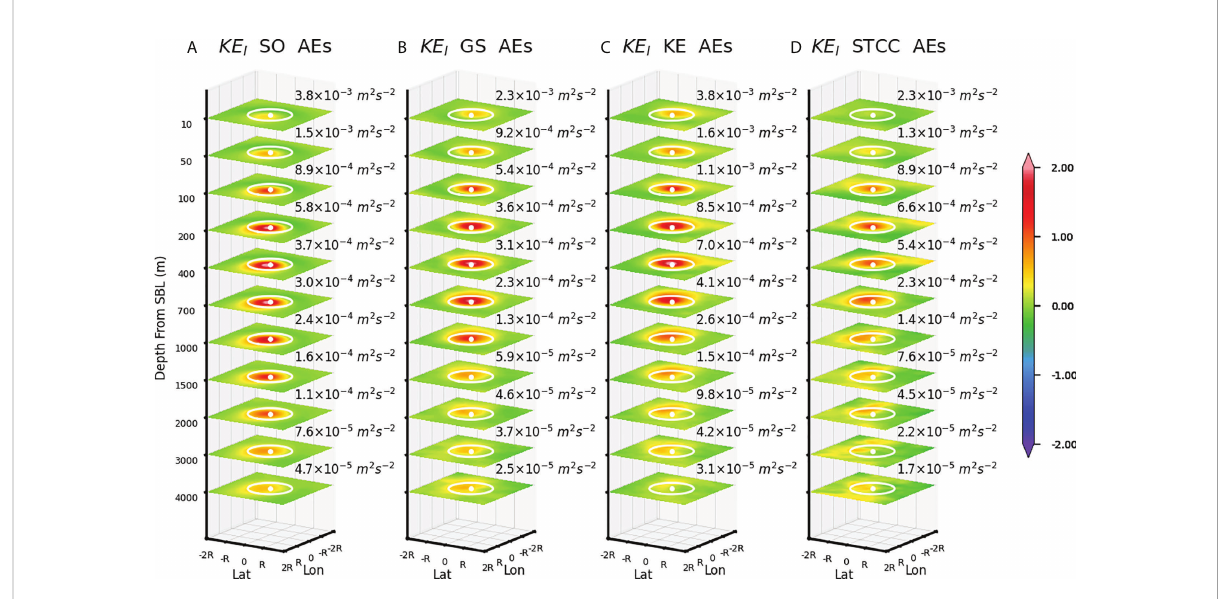
FIGURE 4 Same as Figure 2A but for AEs in the (A) Southern Ocean (SO), (B) Gulf Stream (GS), (C) Kuroshio extension (KE), and (D) subtropical countercurrent (STCC), respectively.